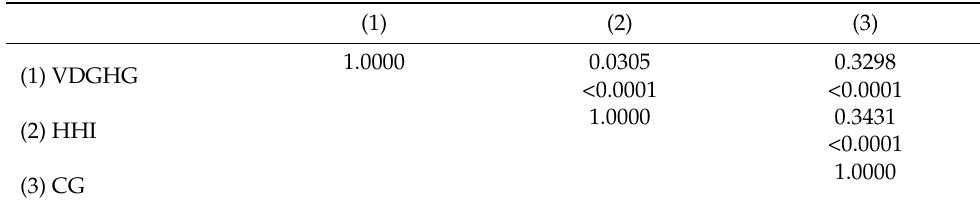
Table 3. Pearson Correlation.